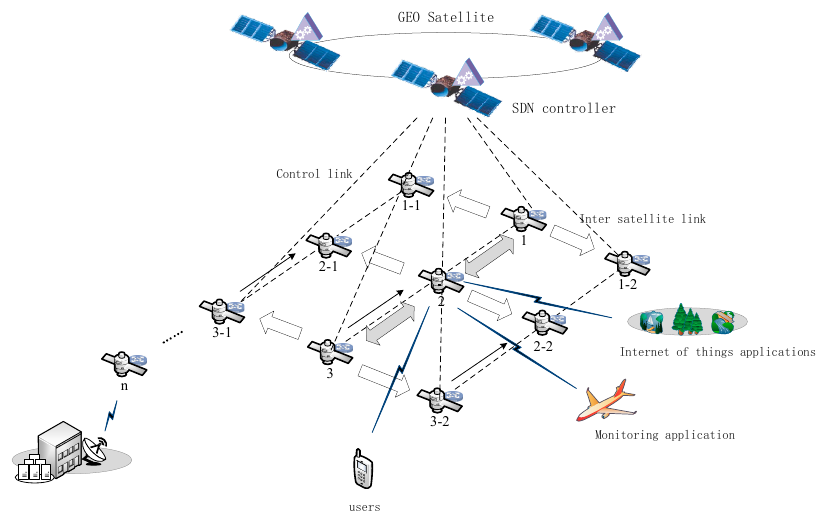
Figure 1. The satellite network scenario.